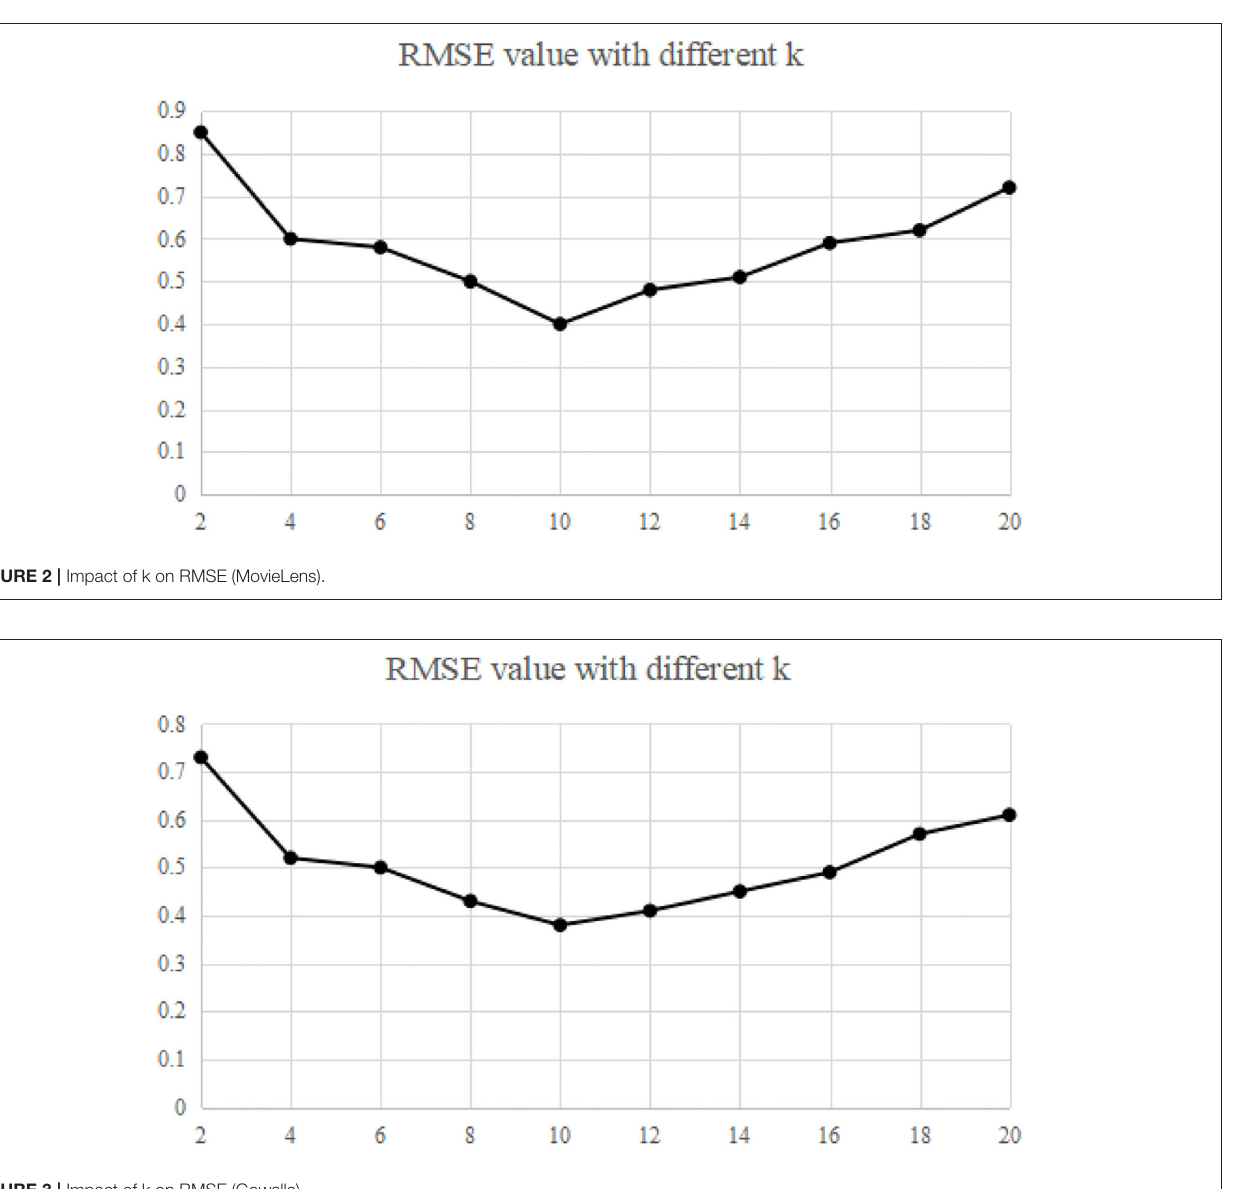
FIGURE 3 | Impact of k on RMSE